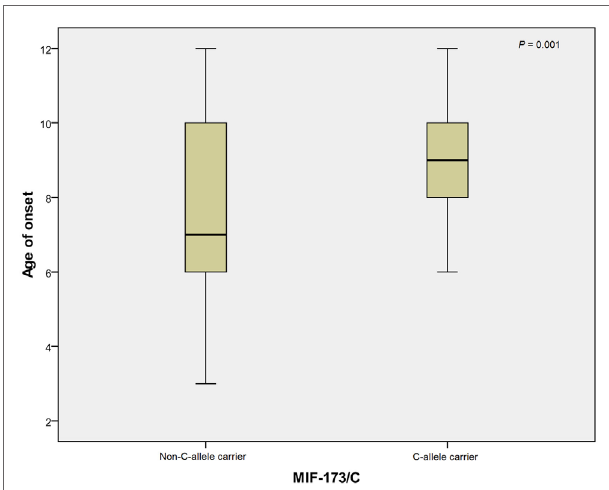
FigUre 1 | Mean of age at onset for 173c allele non-carriers ( N = 94) and carriers ( N = 28) . The mean age at onset of non-C allele carriers and C allele carriers were 7.5 ± 2.4 and 9.2 ± 1.6, respectively. N ,